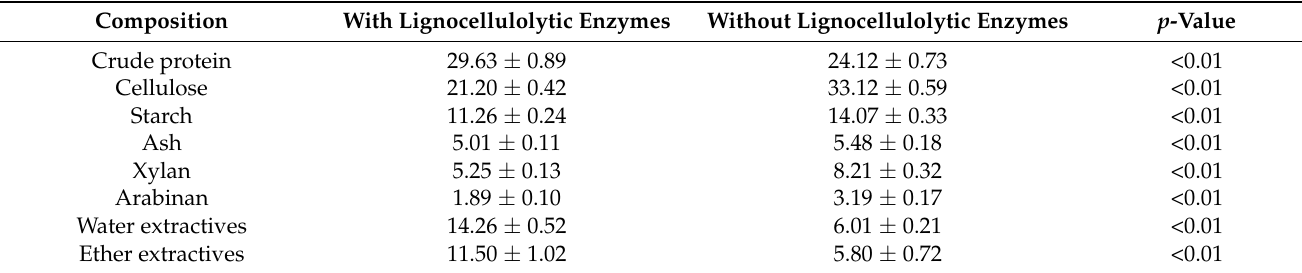
Figure 1. Further degradation of residual SSF broth after ethanol evaporated by lignocellulolytic enzymes cocktail. Table 4. Composition of DDGS with/without lignocellulolytic enzymes Table 3. The composition analysis of unutilized corn mash after SSF and SHF with/without ligno- cellulolytic enzymes addition.